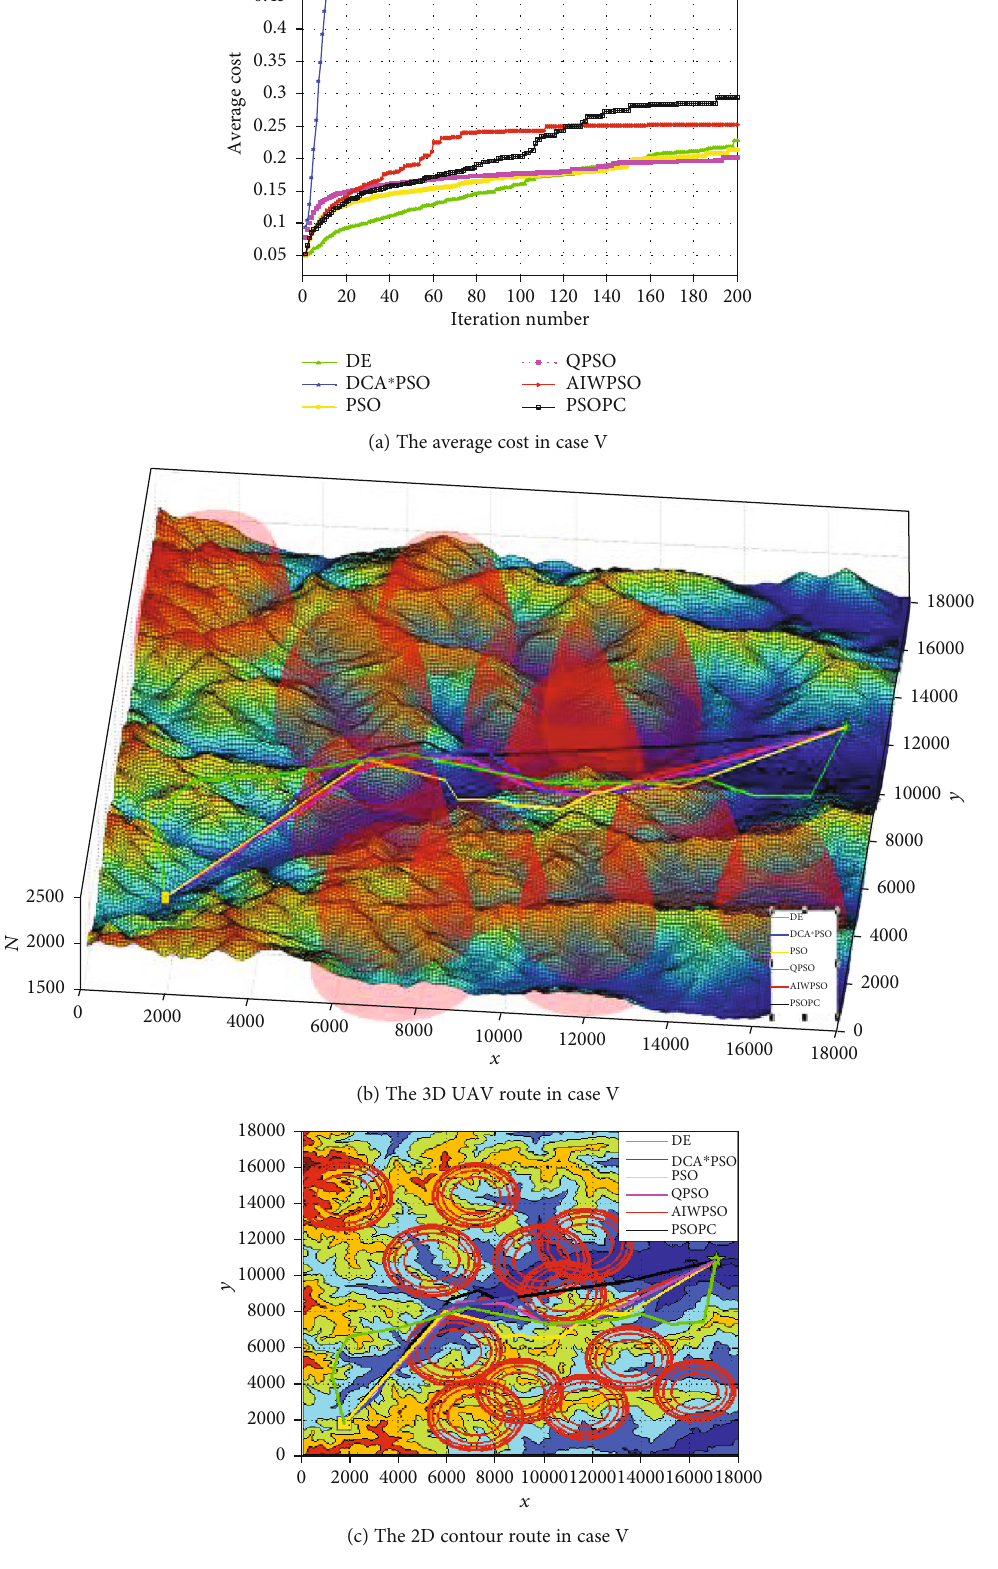
Figure 10: The comparison results of various methods in case